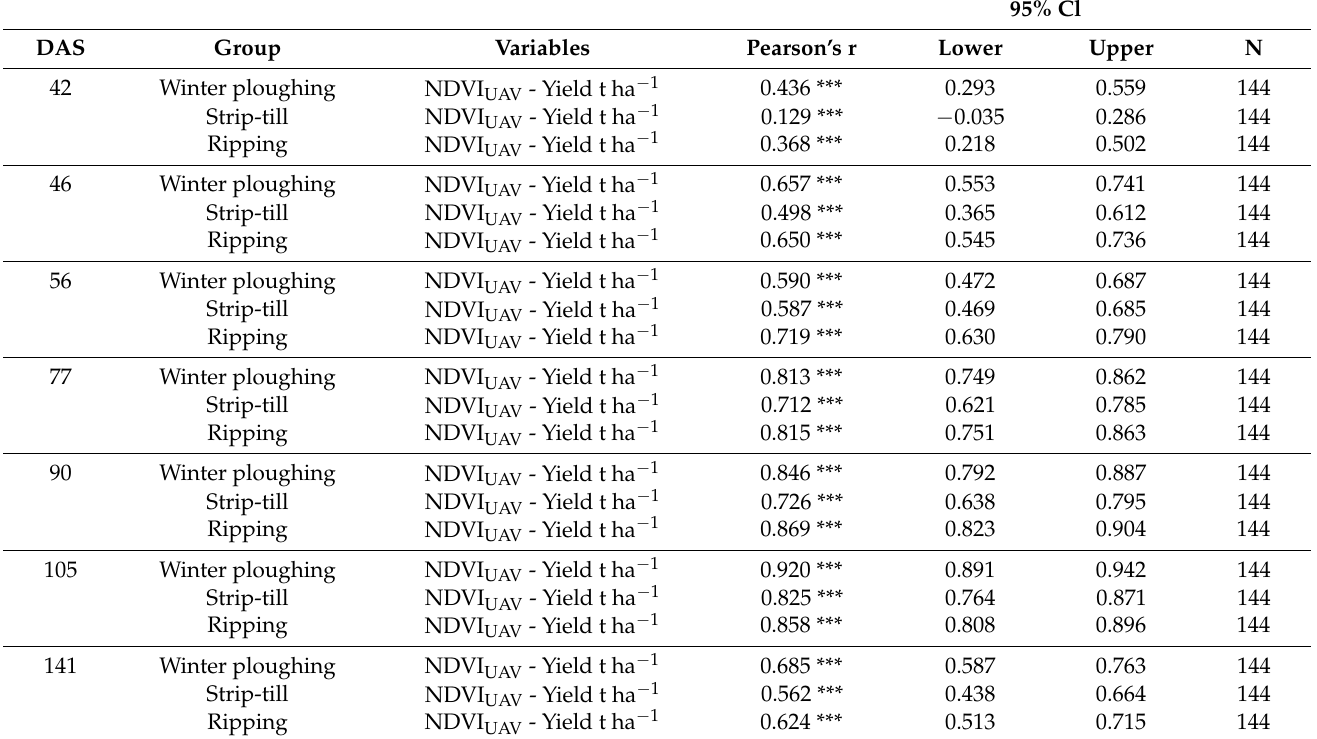
Table 4. Pearson correlation coefficient (r) values among NDVI UAV and yield t ha − 1 as a result of tillage systems (2021, Debrecen).